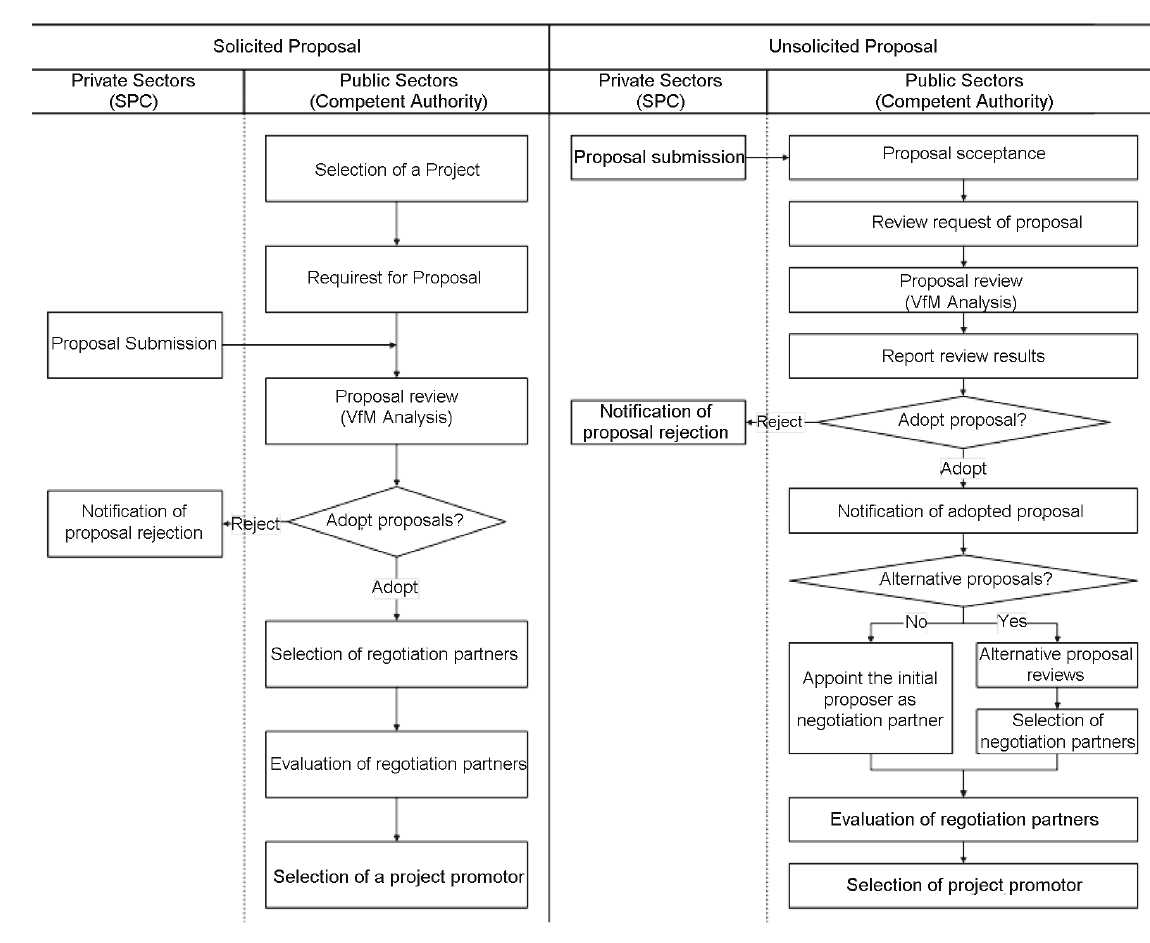
Fig. 2. Project promoter selection procedures depending on the proposal modes (MOSF